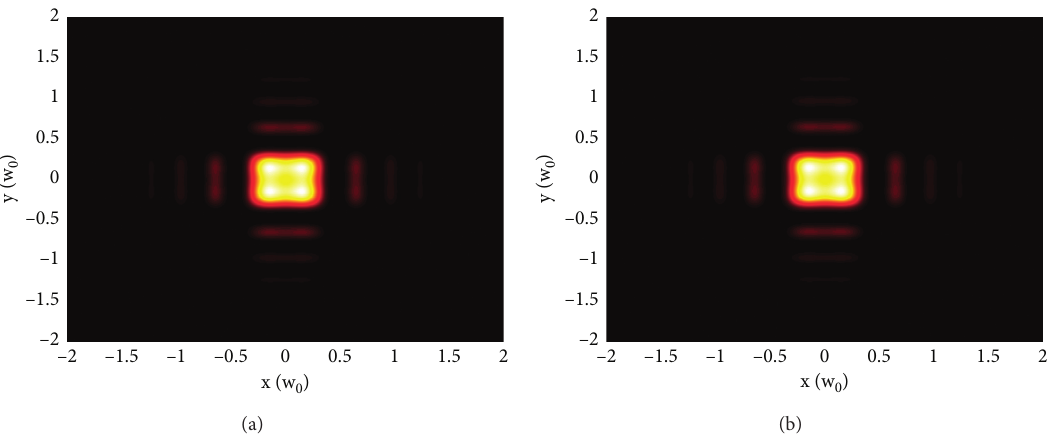
� 0.1: (a) σ � 0.5mm; 0